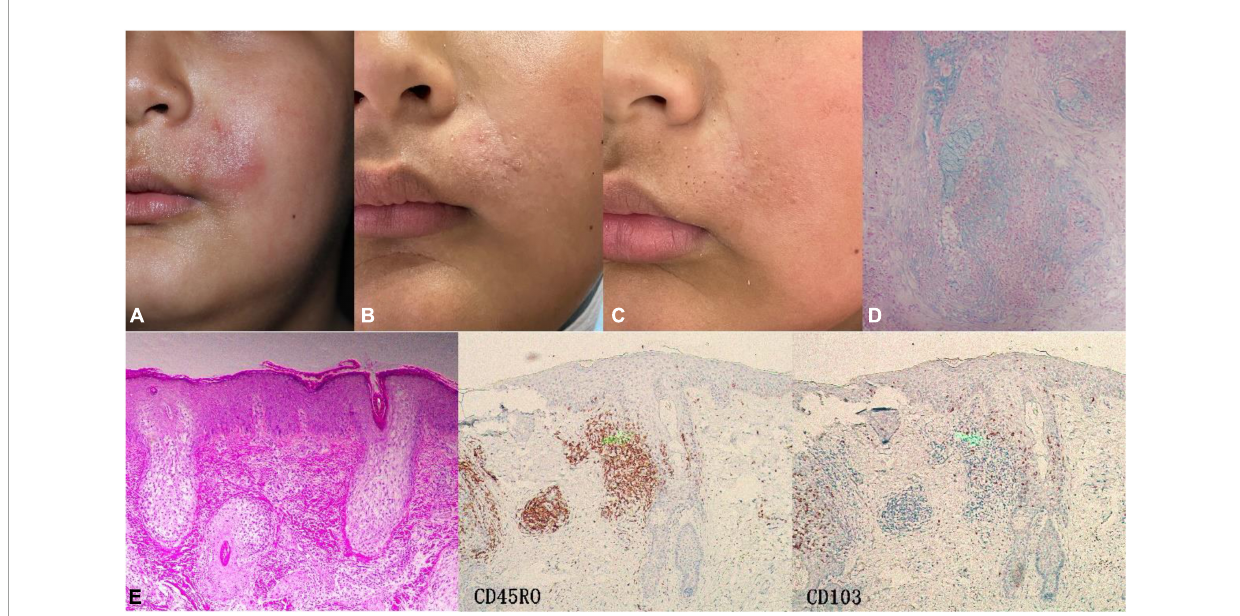
FIGURE1 Case3 (P-FM). (A) The boy presented with perioral infiltrating red plaque on the left side at first visit. (B) After 2 months of oral hydroxychloroquine, most of the lesions subsided with a little scale. (C) After 5 months of oral hydroxychloroquine, the skin lesions basically regressed, leaving enlarged pores. (D) Alcian blue staining was positive. (E) Histopathology showed enlarged, distorted hair follicle expanded by pools of intrafollicular mucin deposition. IHC, CD45RO (++) CD103 (+–).